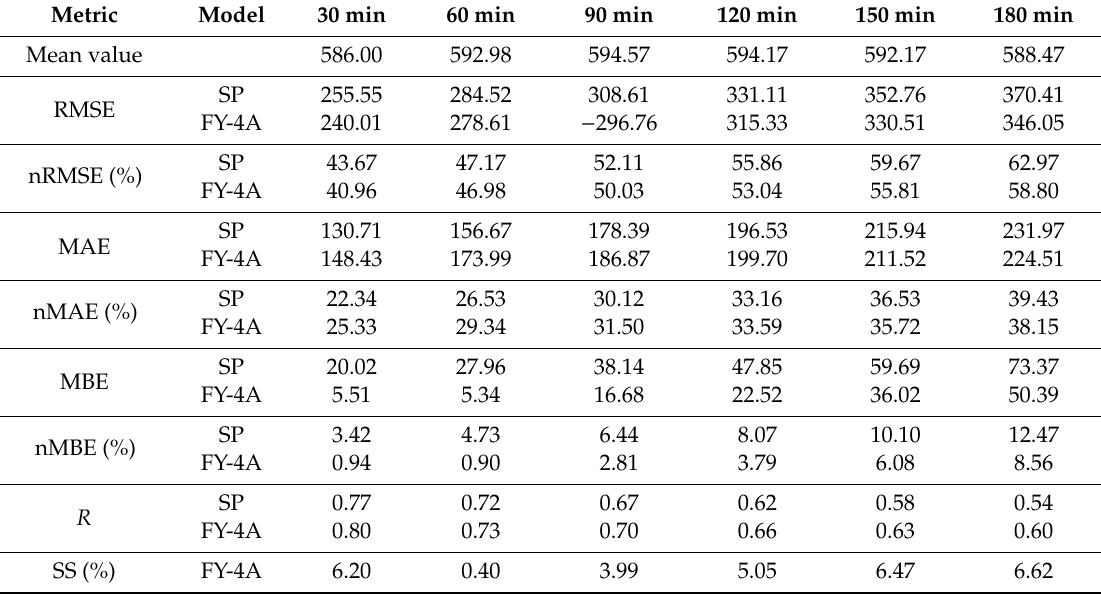
Table 2. Statistical indexes for DNI value for 30–180 min time horizon of the four month (W / m 2 for mean value, RMSE, MAE, and